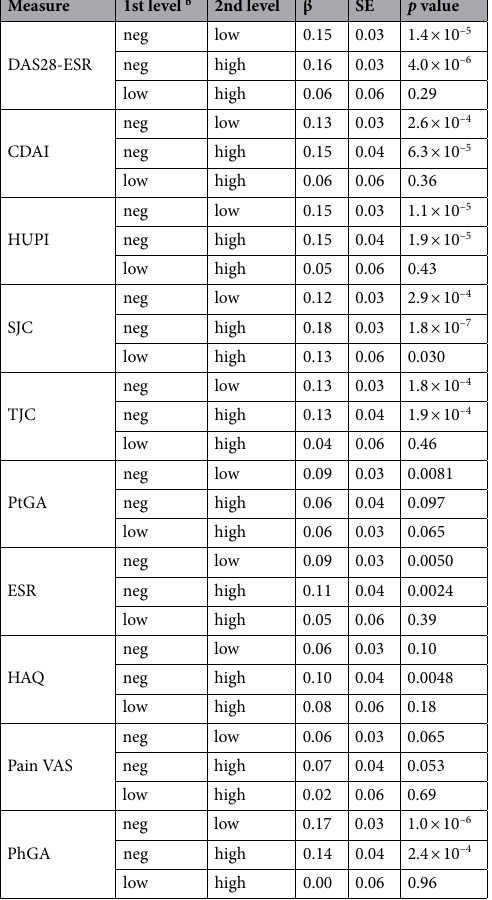
Table 5. Stronger association of SJC with high than with low levels of ACarPA a . a Data from 974 to 978 patients were available for analyses except 902 for CDAI, 949 for HAQ, 966 for Pain VAS, and 903 for PhGA. b The slope coefficients (β) with their standard errors (SE), and p values corresponding to the three specified comparisons in the unadjusted analysis are presented. The cut-off between low and high positive ACarPA was 3× the upper limit of normal.